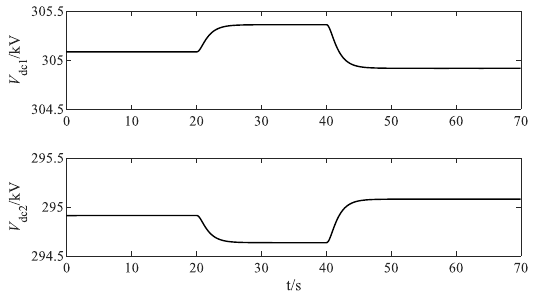
Figure 10. DC voltage variation of proposed control under sudden load changes.